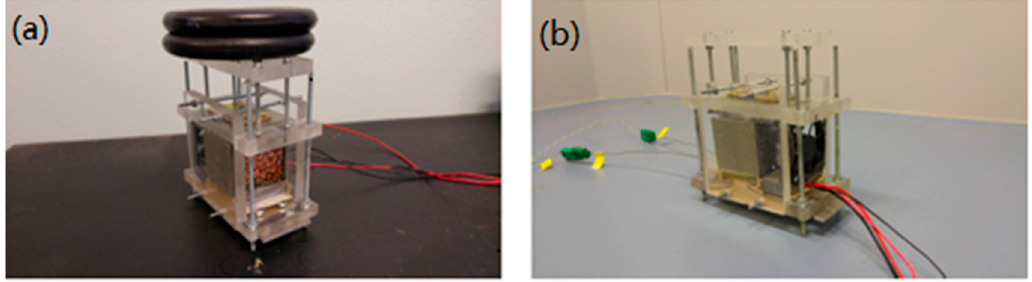
Figure 4. Experimental setup. ( a ): Housing with load; ( b ): housing without load.